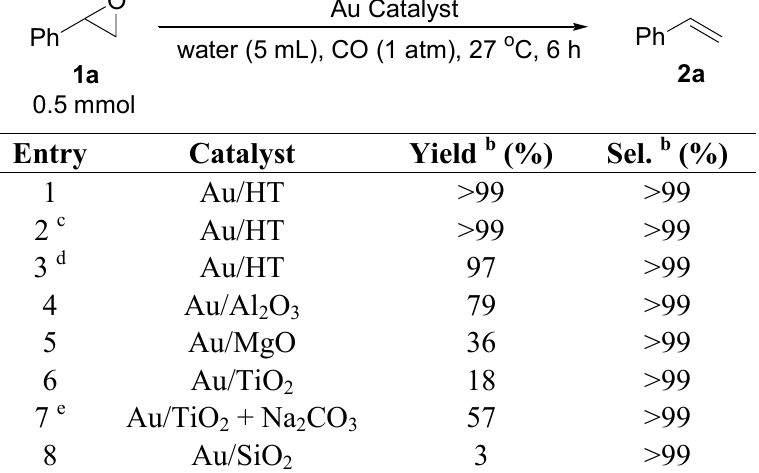
Table 3. Deoxygenation of styrene oxide using CO/H